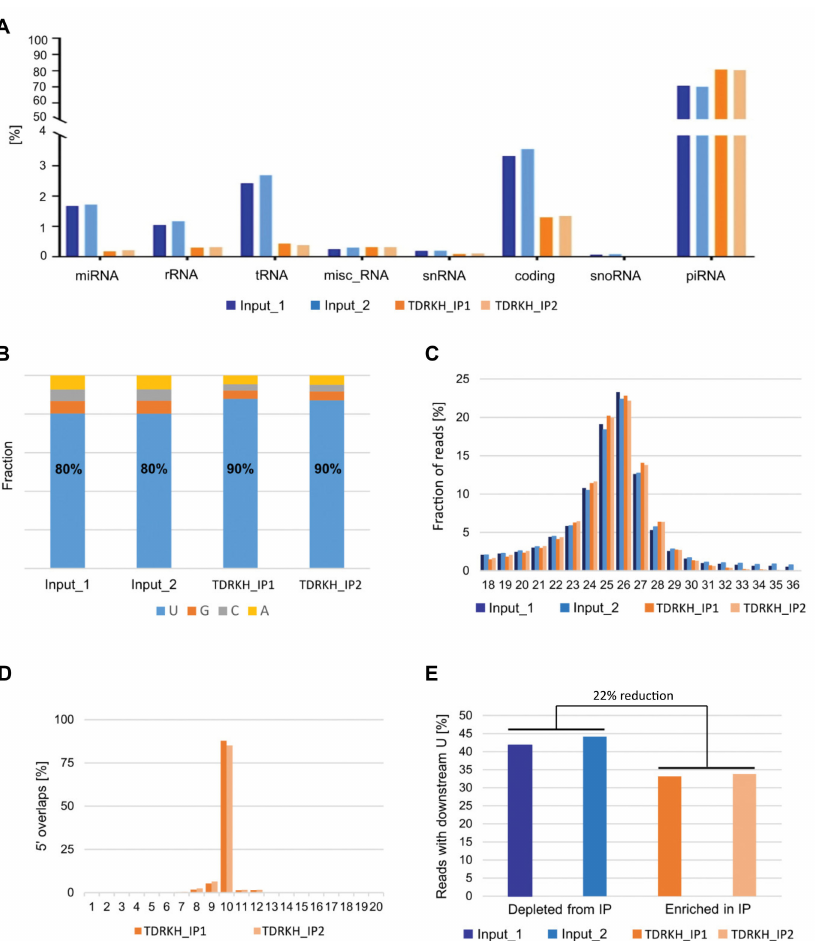
Figure 5. Analyses of piRNA sequences detected after TDRKH immunoprecipitation. Input 1, 2: duplicate total RNAs (blue). TDRKH_IP1, 2: duplicate immunoprecipitated RNAs (orange). ( A )